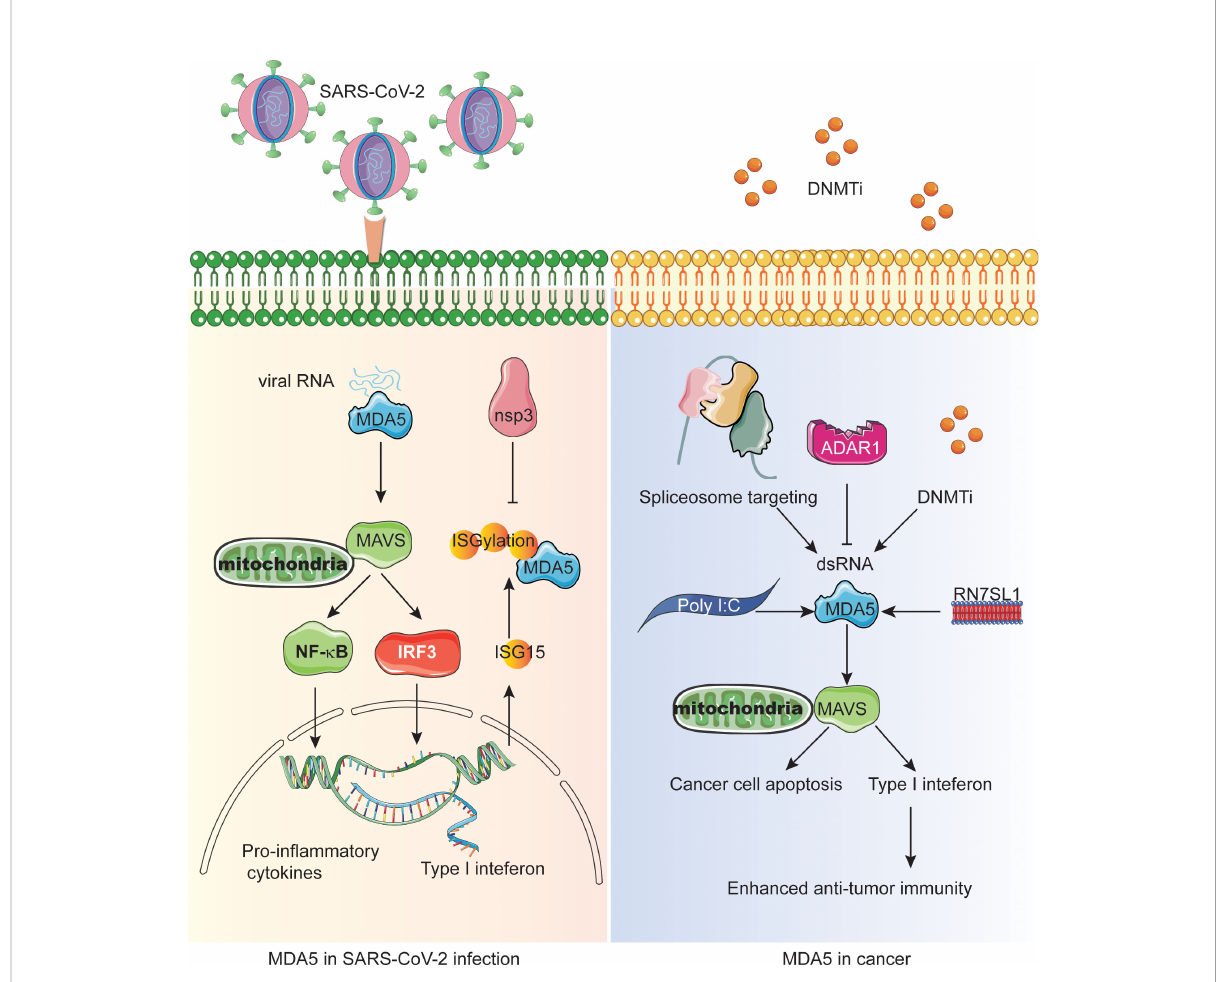
FIGURE 1 The central role of MDA5 in SARS-CoV-2 infection and interferon-mediated anti-tumor immunity. The left panel shows the MDA5-MAVS-NF k B/ IRF3 signaling during SARS-CoV-2 infection and how the nonstructural proteins inactivate MDA5 through deISGylation. The right panel shows the different mechanisms resulting in endogenous dsRNA production or MDA5 activation in cancer cells which enhances the antitumor immunity and/or cancer cell